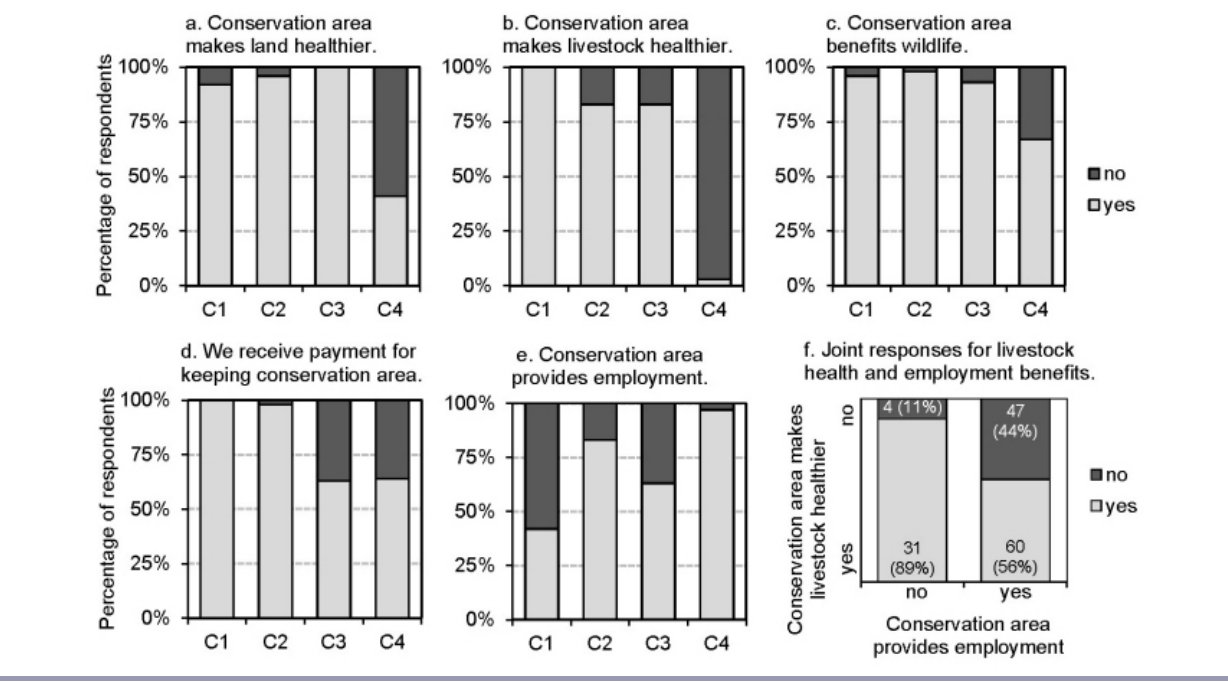
Fig. 3 . Perceived benefits from conservation areas and economic inputs from conservation partner organizations. (a-e) Community member responses to the question, “Do you think your conservation area is good because … ?” The panel titles complete the sentence. (f) Contingency analysis of livestock health perceptions by perceptions of employment benefits. The columns separate respondents according to their perceptions of employment benefits from their conservation area, and the dark/light division within columns shows their perceptions of conservation area benefits for livestock health. In each block, sample size and percentage of column total are given. In all panels, analyses revealed significant variation at the α = 0.05